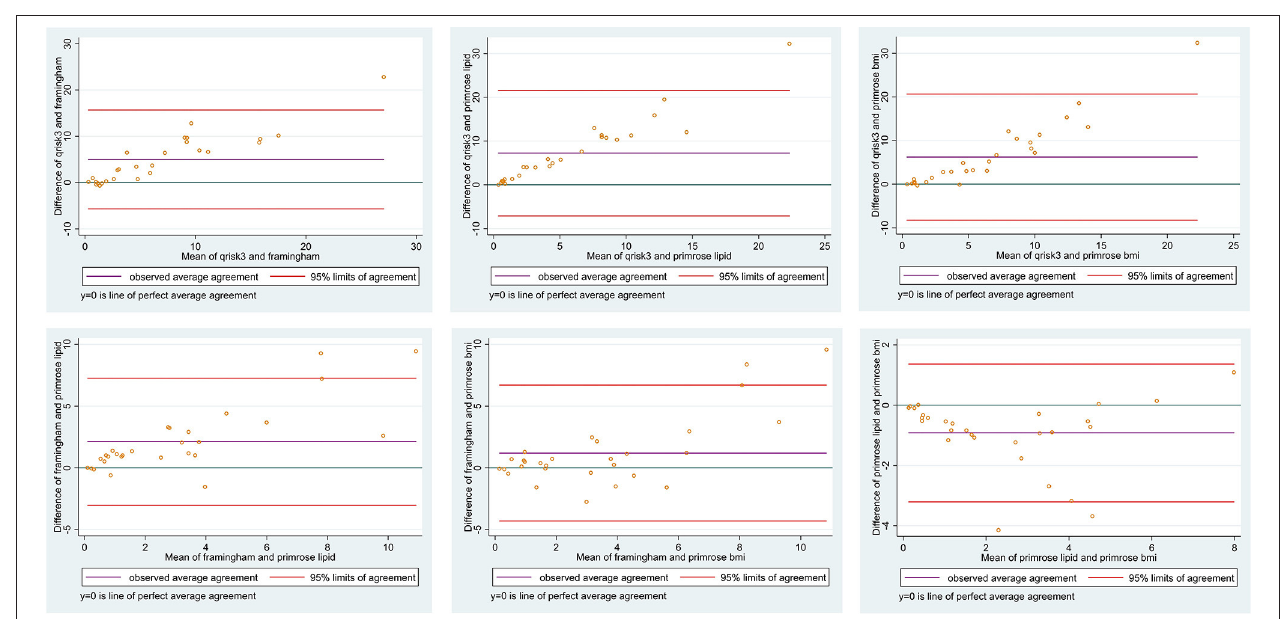
FIGURE 4 | Difference against mean between 10-year predicted CVD risk